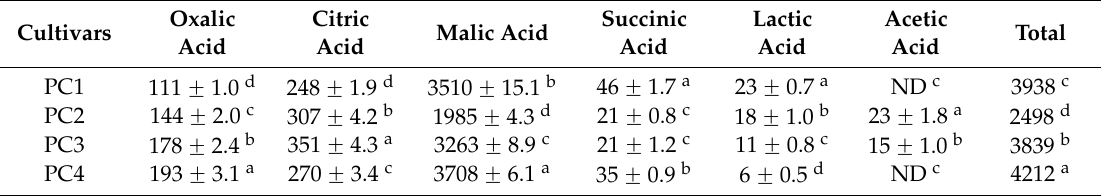
Table 5. Organic acids composition of persimmon seeds, expressed in (mg/kg dry weight). Succinic Lactic Acetic Oxalic Citric Total Malic Acid Cultivars Acid Acid Acid Acid Acid PC1 111 ˘ 1.0 d 248 ˘ 1.9 d 3510 ˘ 15.1 b 46 ˘ 1.7 a 23 ˘ 0.7 a ND c PC2 144 ˘ 2.0 c 307 ˘ 4.2 b 1985 ˘ 4.3